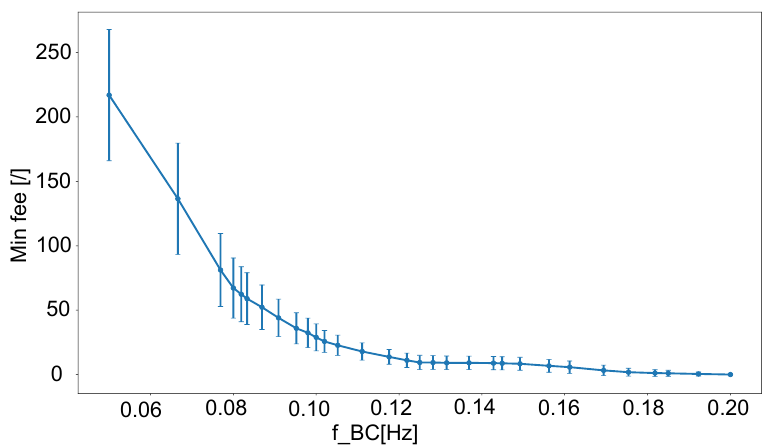
Figure 17. Minimum transaction fee in the game for different frequencies of transaction